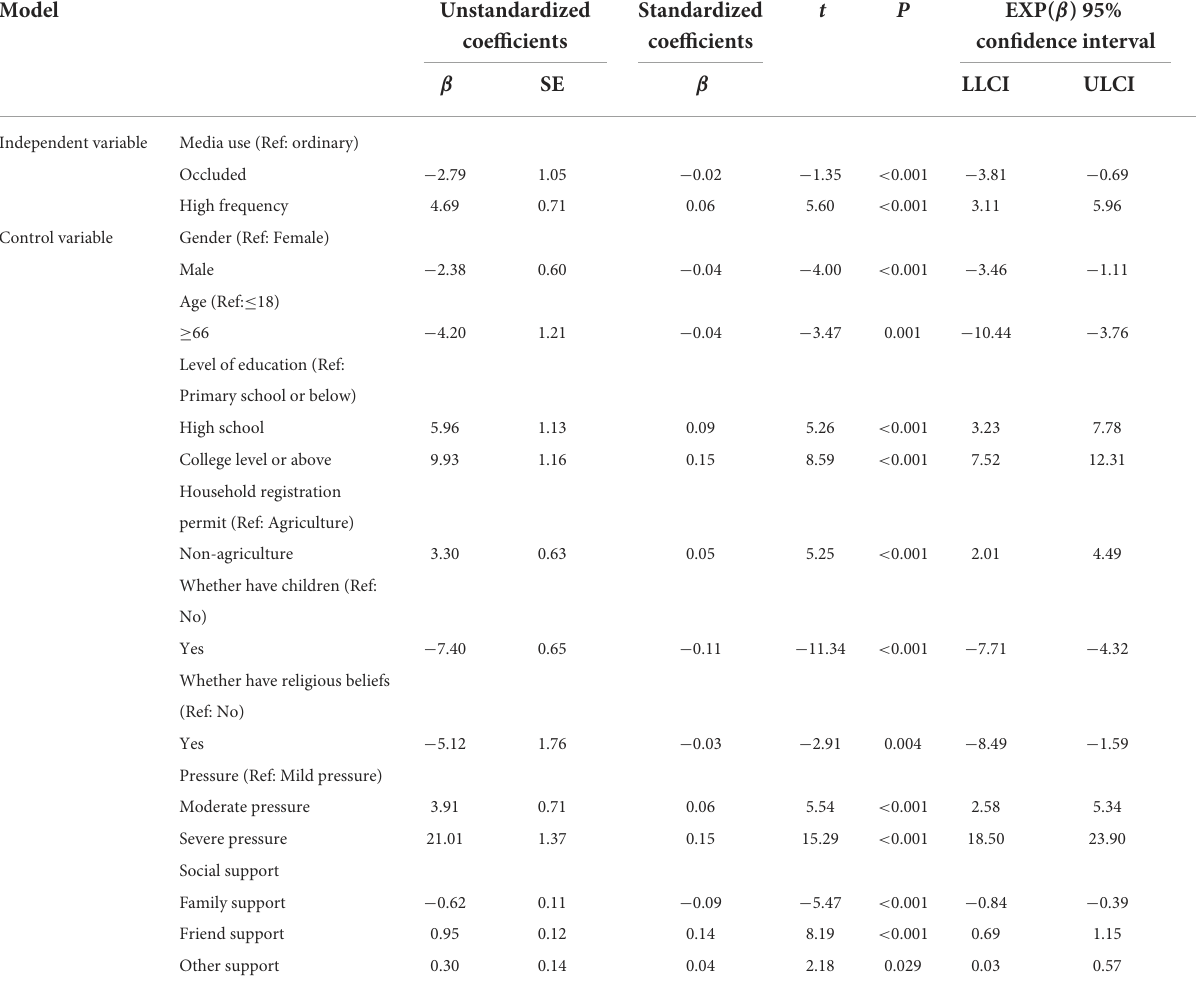
TABLE 4 Regression analysis of media use on the accept willingness to organ donation.